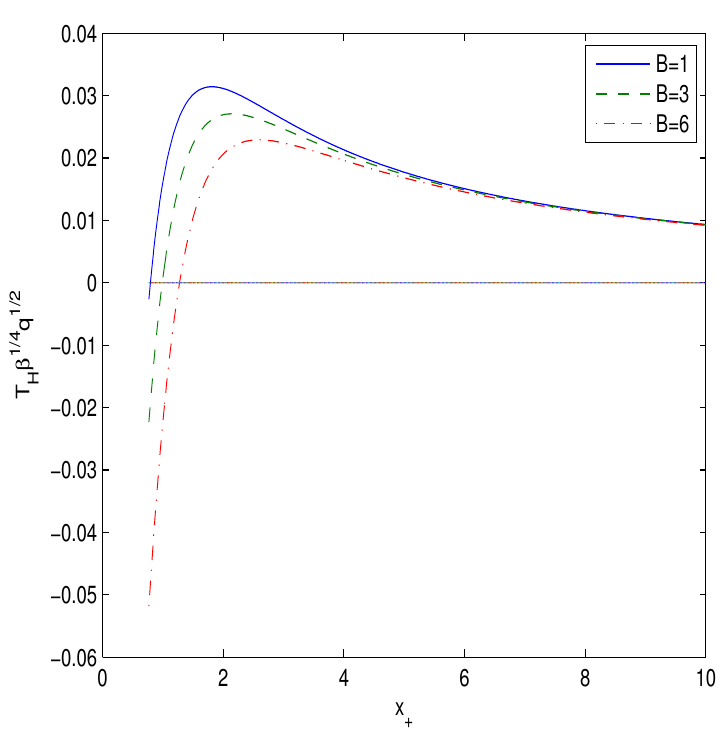
(cid:112) Figure 2. The plot of the function T H ( x + ) 4 β q 2 at C = 1. According to Equation (17), the heat capacity possesses a singularity when the Hawking temperature has an extremum, ∂ T H ( x + ) / ∂ x + = 0. It follows from Equations (16) and (17) that at some point, x + = x 1 , the Hawking temperature and heat capacity are zero where a first-order phase transition occurs. In this point, x 1 , the BH remnant with nonzero BH mass is formed, but the Hawking temperature and heat capacity become zero. In the point x = x 2 , ∂ T H ( x + ) / ∂ x + = 0, the heat capacity has a discontinuity, and the second-order phase transition occurs. In the interval x 2 > x + > x 1 , BHs are locally stable, and at x + > x 2 , the BH becomes unstable. By using Equations (17), (19), and (20), we represented the heat capacity in Figure